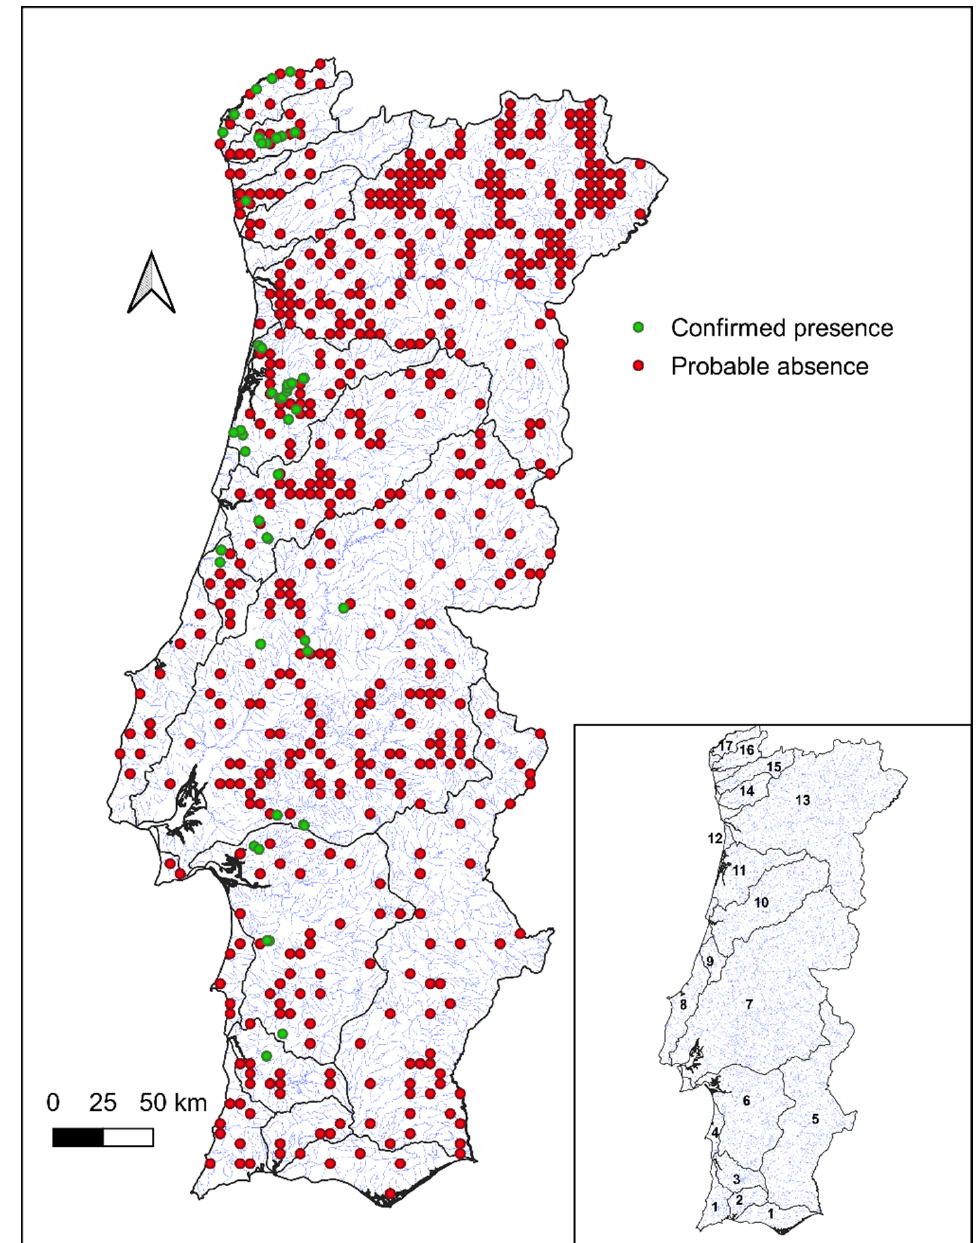
Figure 1. Distribution of the sampling sites ( N = 646) according to the presences and absences observed for the target species. Green circles indicate sites where the presence of G. aculeatus was confirmed, and red circles indicate probable absence. The map in the lower right corner of the figure shows the location of the main Portuguese river basins: (1) small independent streams of Algarve, (2) Arade, (3) Mira, (4) small independent streams of Alentejo, (5) Guadiana, (6) Sado, (7) Tagus, (8) small independent systems of Oeste, (9) Lis, (10) Mondego, (11) Vouga, (12) small independent streams between Douro and Vouga River basins, (13) Douro, (14) Ave, (15) Cávado, (16) Lima and (17) Minho.